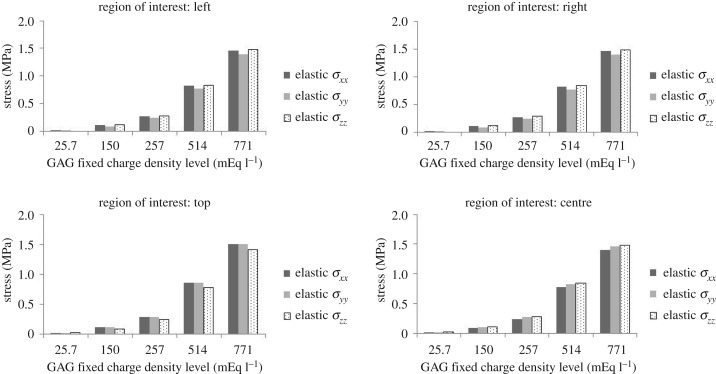
Maximum elastic stresses σxxe, σyye and σzze in four ROIs for GAG inclusion FCD at 25.7, 150, 257, 514 and 771 mEq l−1.